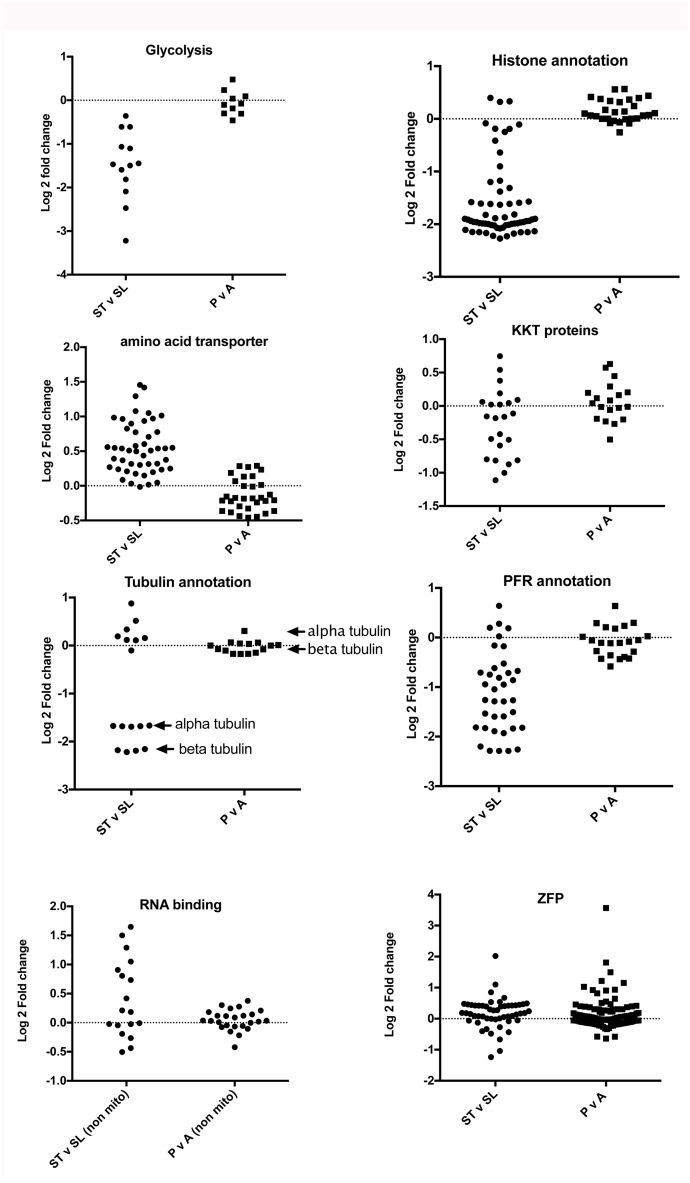
Differential expression of components of different biological processes in T. congolense and T. brucei.Log2 fold change of transcripts associated with different functional processes in peak versus ascending parasitaemia T. congolense, or stumpy versus slender T. brucei. For glycolysis, the relevant pathway enzymes were analysed (and their orthologues in T. congolense). For the other comparisons, annotation-based criteria (‘histone’, ‘amino acid transporter’, ‘KKT protein’, ‘tubulin’, ‘paraflagellar rod’, ‘RNA binding’ or ‘zinc finger protein’) were used to analyse each functional class. In the case of ‘histones’ this also included histone modifying enzymes; for the ‘RNA binding’ group this included pumillio class proteins as well as non-mitochondrial RNA binding proteins.